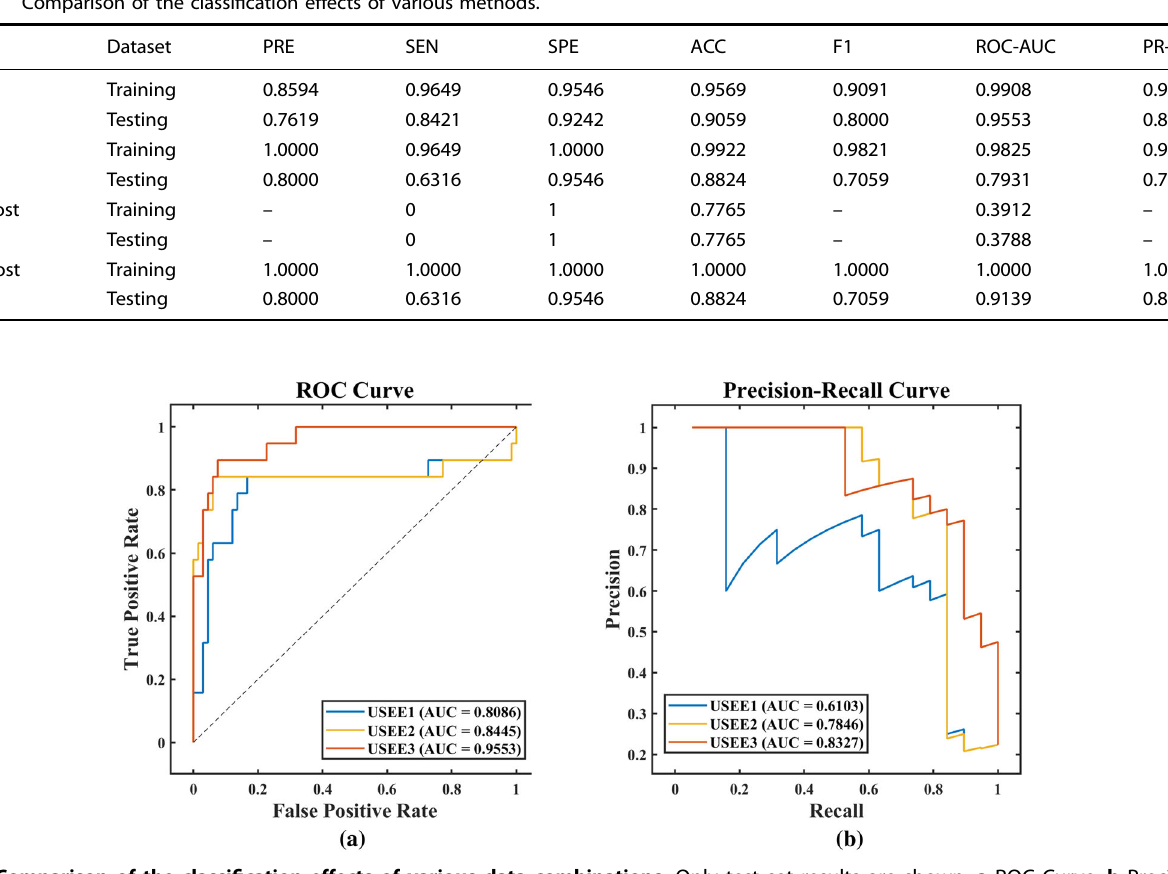
Table 5. The fi tting curve of the regression effect evaluation also